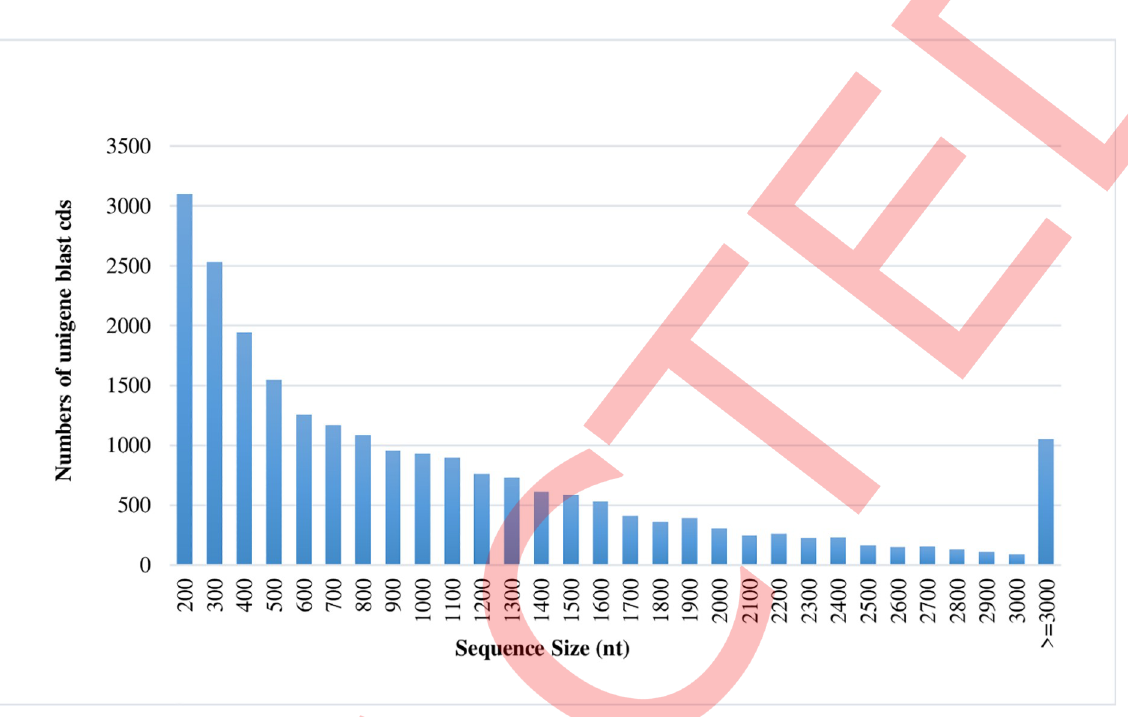
Fig 10. Length distribution of unigenes from CDS of Rhynchophorus ferrugineus fat body tissues transcriptome data. Nucleotide sequence size (nt) and numbers of unigenes BLASTed are indicated on the X- and Y-axes, respectively.